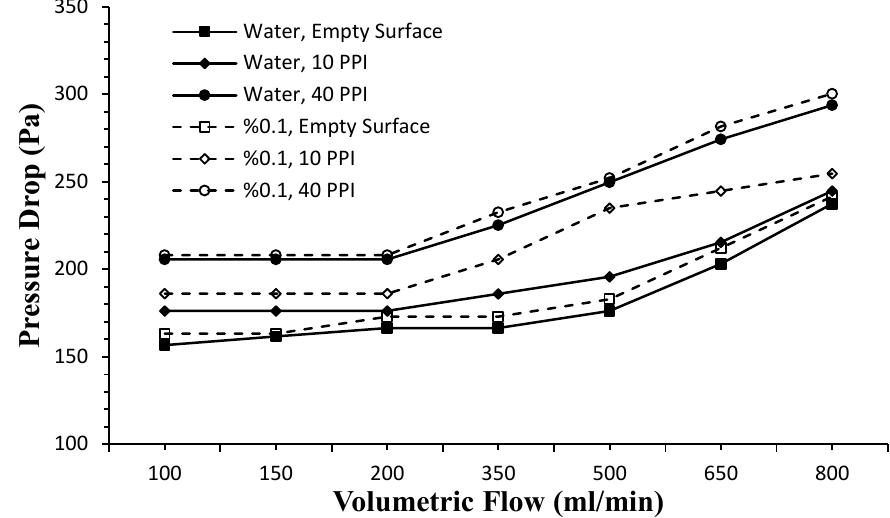
Figure 5. Effect of using nanofluid and porous HS on pressure drop.